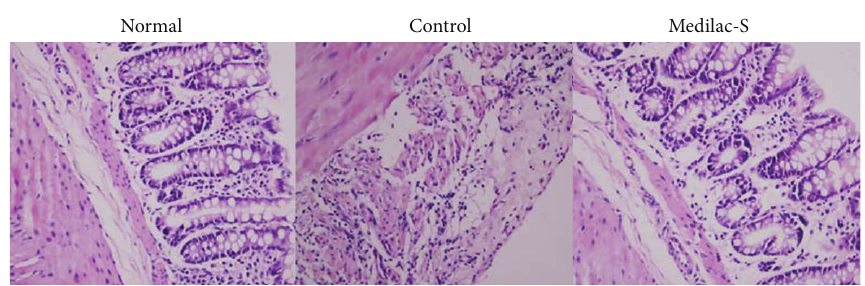
Figure 1: Morphological analysis of the lower segments of colons from normal, control, and Medilac-S rats. H&E staining with a magnified view × 200 shows significant histological changes in groups. In the control group, the glands were destroyed to a certain extent. An amount of neutrophils and lymphocytes was seen in intestinal tissue and a few eosinophils infiltrated into the intrinsic layer and submucosa. But in the Medilac-S group, few inflammation cells were seen (bars = 200 𝜇 m).